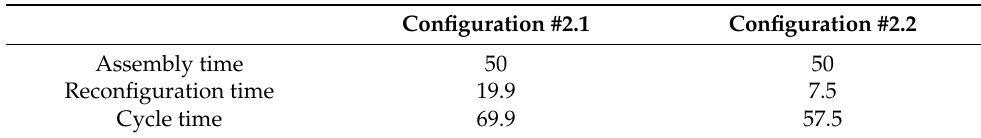
Table 5. Cycle time [s/pc] decomposition (assembly and reconfiguration) in Configuration #2.1 and #2.2.